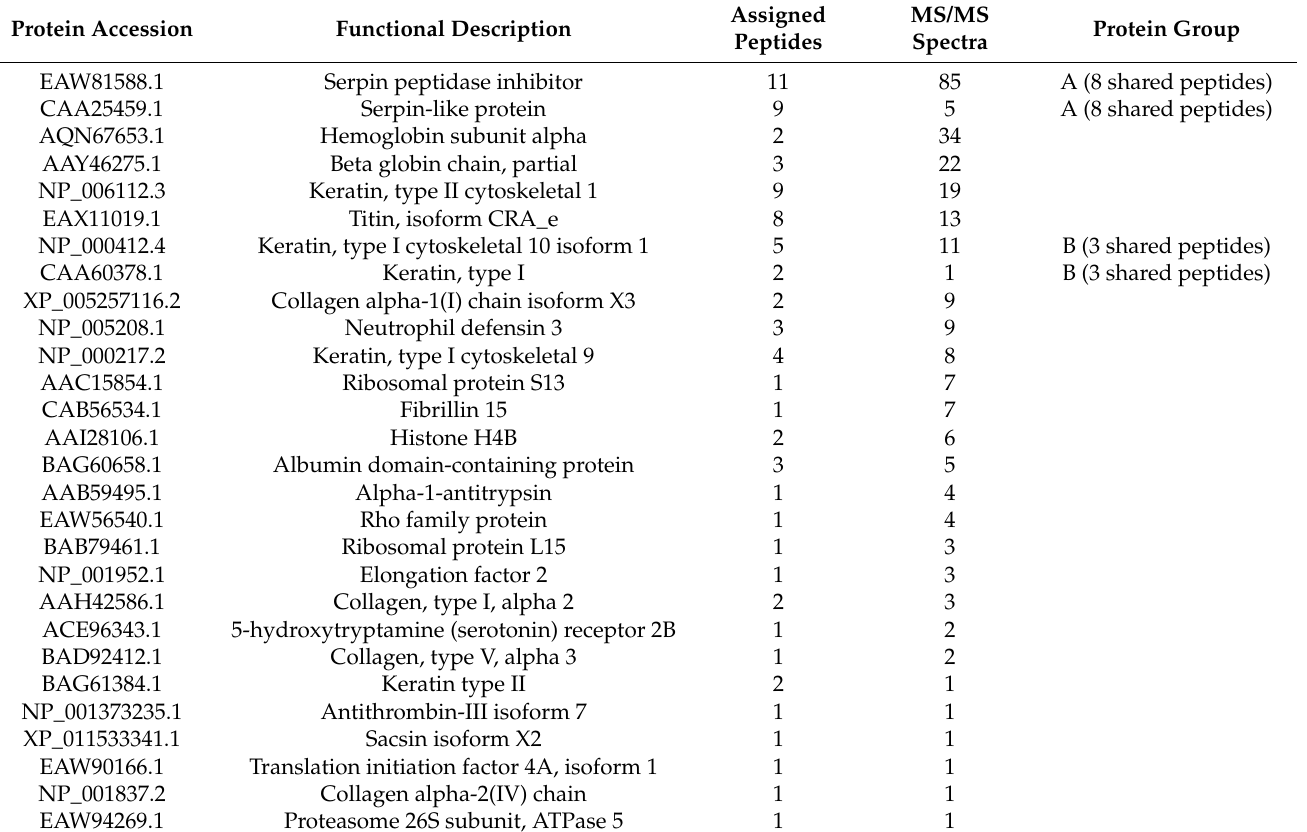
Table 2. Human proteins ranked by their abundances, assessed by the number of MS/MS